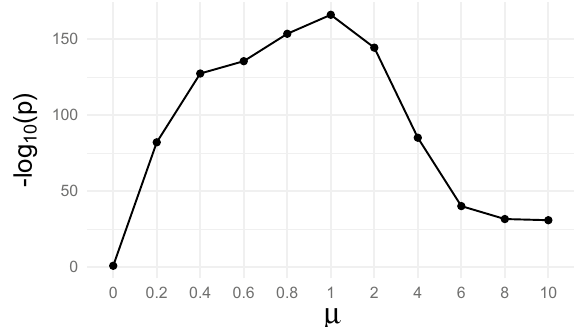
Figure 4. Effect of different weights on performance. It shows the negative logarithm of Fisher’s meta analyzed p-value with different weight values.